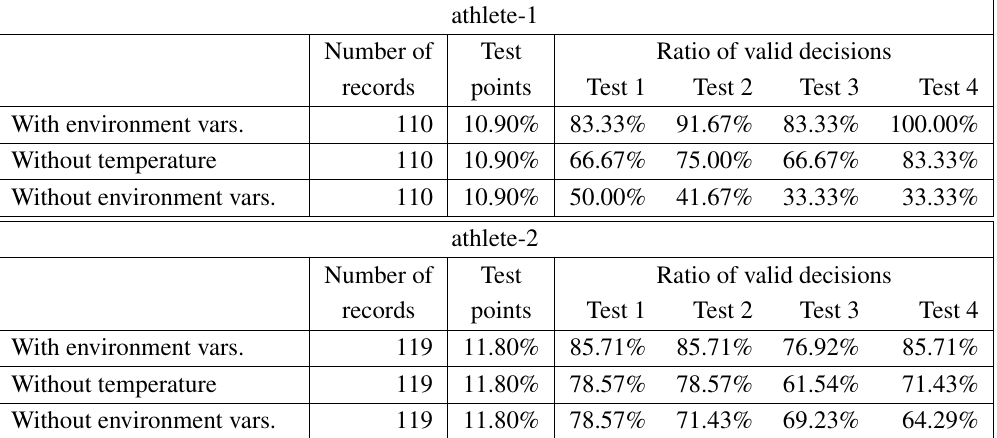
Table 7. Influence of environment variables on the percentage of valid